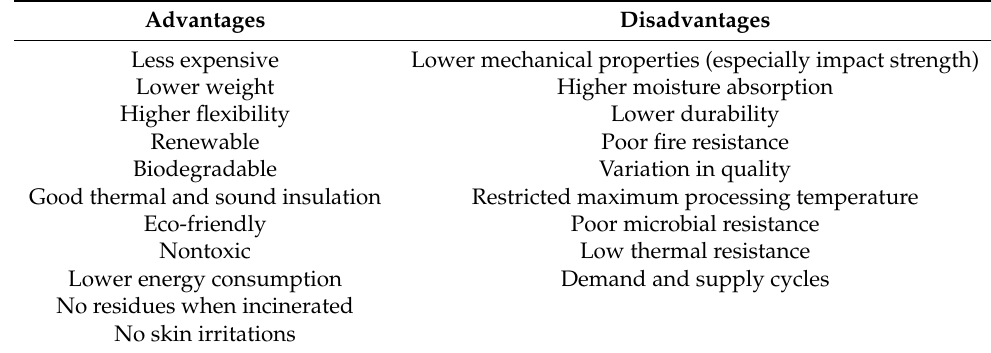
Table 1. Detailed advantages and disadvantages of plant fibers [23].